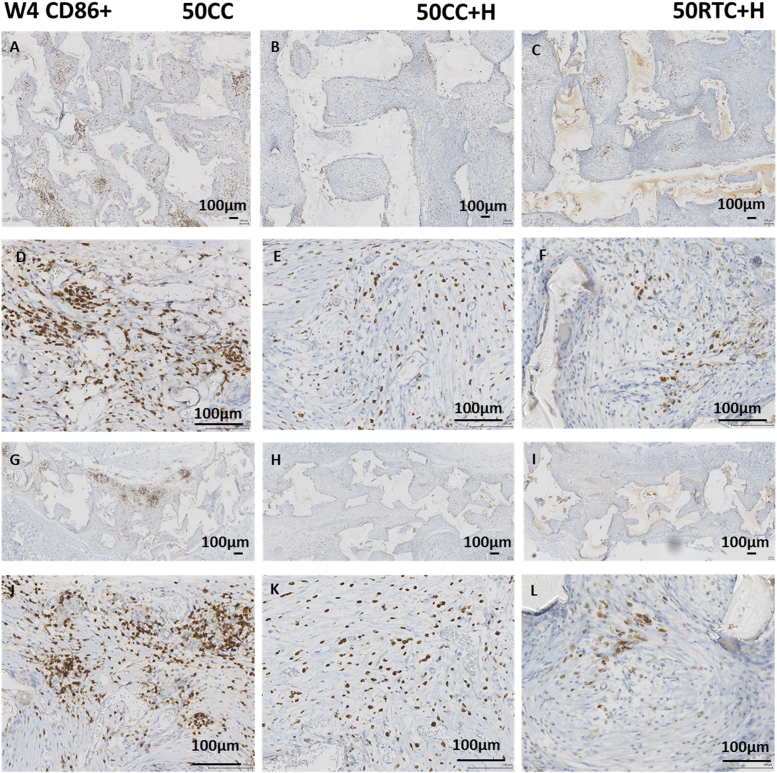
Immunohistochemistry of the host macrophage response towards scaffolds in vivo at week 4. Tissue integration of middle-in-plane (A-F) and cross-sectional view (G-L) of the scaffolds by CD86 (M1 macrophage marker) staining at (A-C, G-I) ×4 and (D-F, J-L) ×20 magnifications.